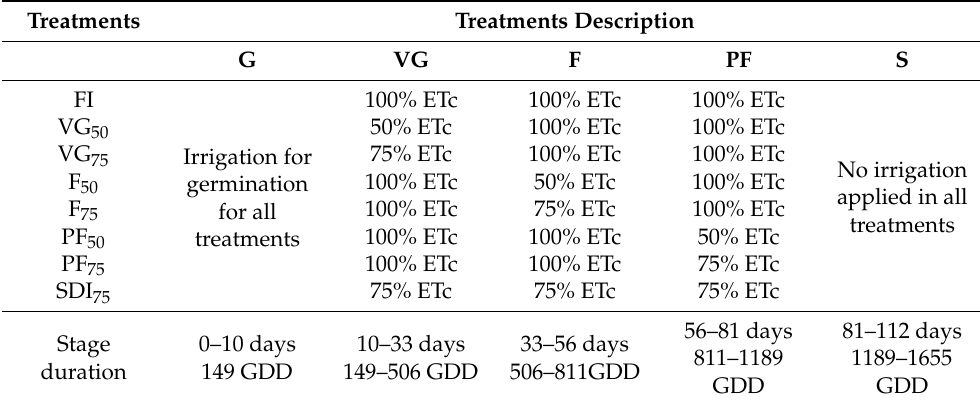
Figure 2. Experimental design for testing RDI and SDI on the Blanoro variety of Chickpea during years 2020 and 2021 in Todos Santos, Baja California Sur, Mexico. Treatment acronym in Table 3. Table 3. Deficit irrigation treatments applied to chickpeas for two consecutive years (2020 and 2021) in Todos Santos, Baja California Sur, Mexico.